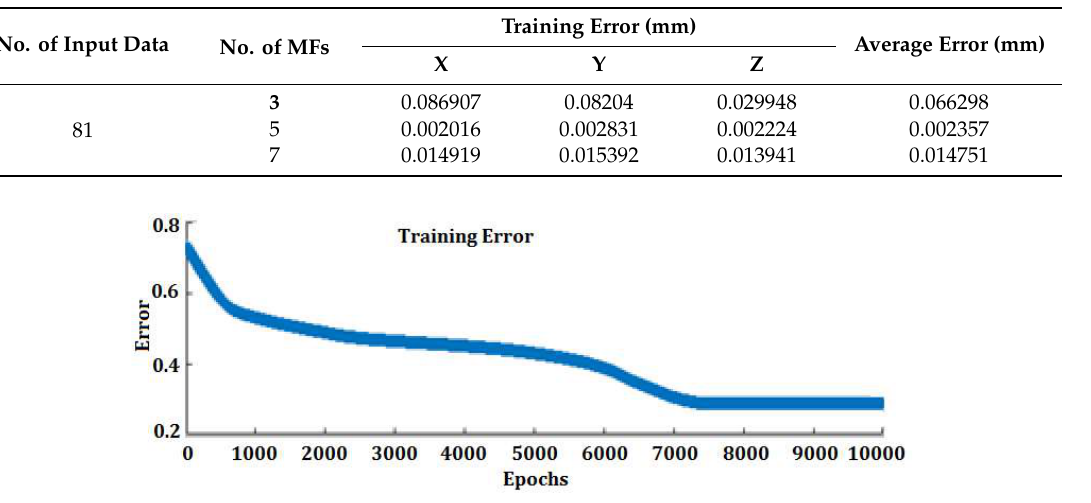
Figure 12. Minimum training error of ANFIS in the target orientation.